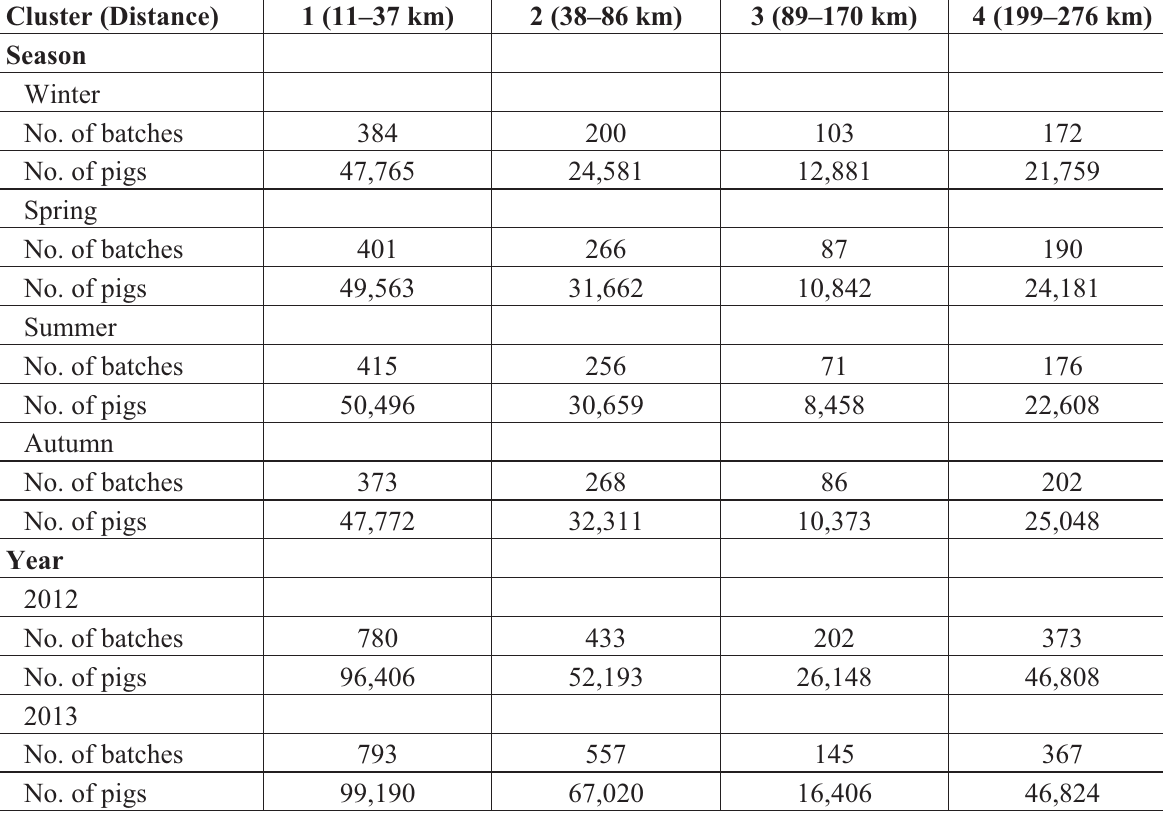
Table 3. Distribution of batches and pigs based on season and